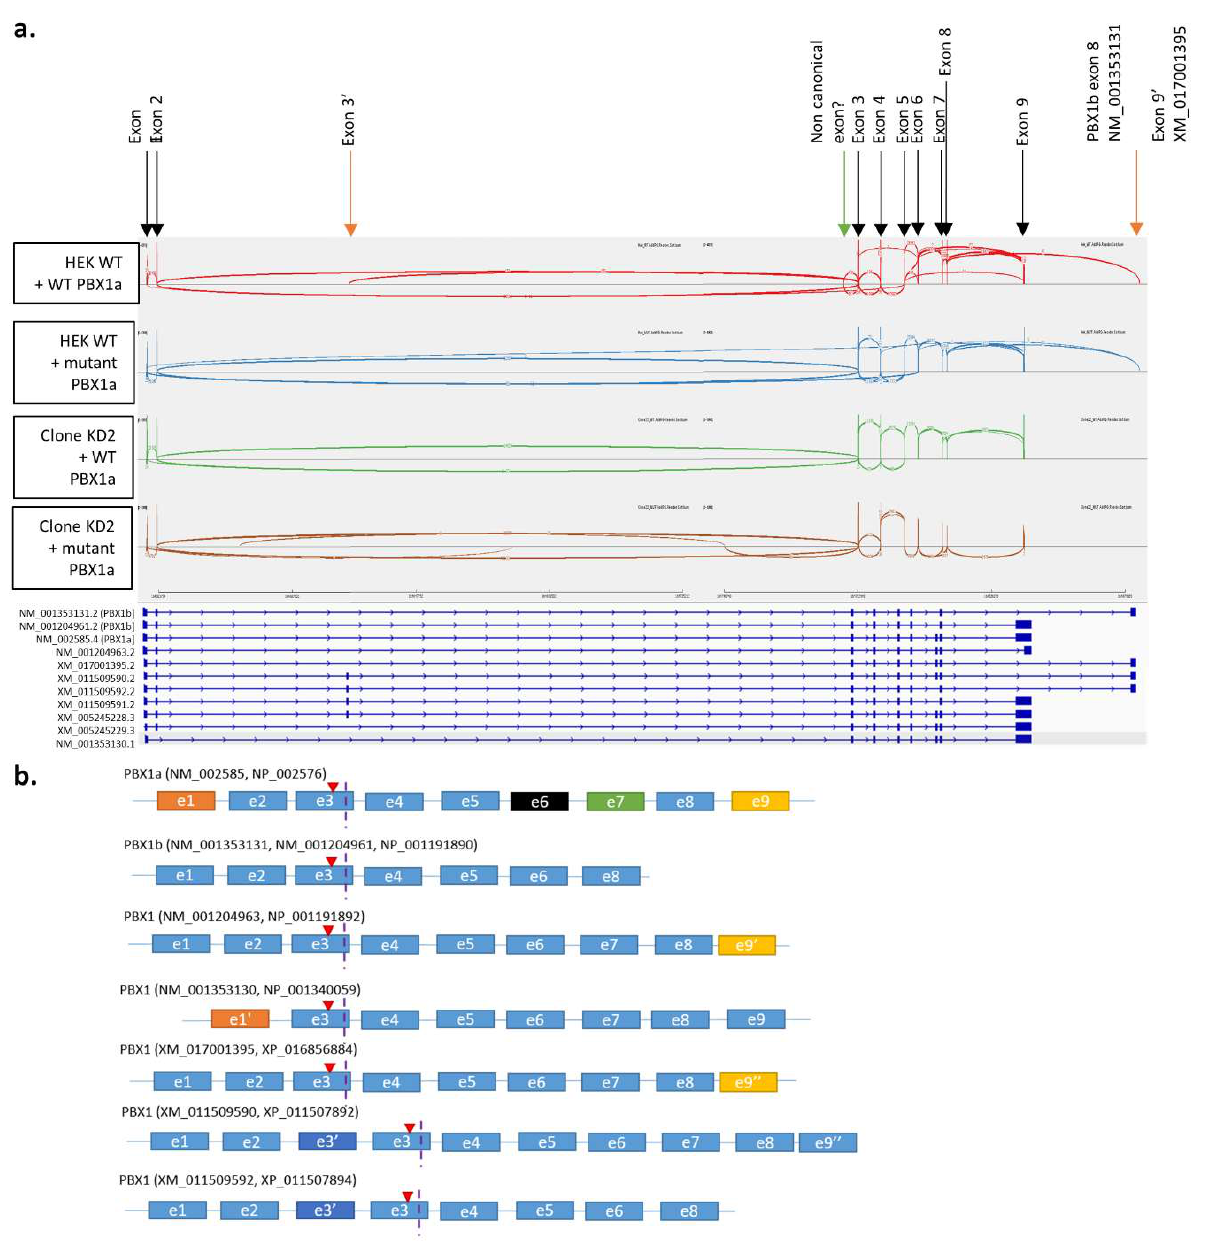
Figure 5. PBX1 transcripts in HEK cells and clone KD2. ( a ) Sashimi plot of PBX1 in HEK cells + WT PBX1a (1), HEK cells + PBX1a-320G>A (2), clone KD2 + WT PBX1a (3), and clone KD2 + PBX1a-320G>A. Exon junction coverages < 5 are hidden for lisibility. Black arrows represent exons of PBX1a isoform (NM_002585). ( b ) Schematic view of PBX1 transcripts. Red triangle represents the location of the c.320G>A mutation. Vertical dotted purple line represents the location of the CRISPR-generated frameshift insertion. Table 1. PBX1 isoforms expressed in transfected cells. WT HEK+WT/mutant: WT HEK cells trans- fected with WT or mutant PBX1a plasmid. Clone KD2 + WT/mutant: KD2 cells transfected with WT or mutant PBX1a plasmid. TPM: transcript per million.